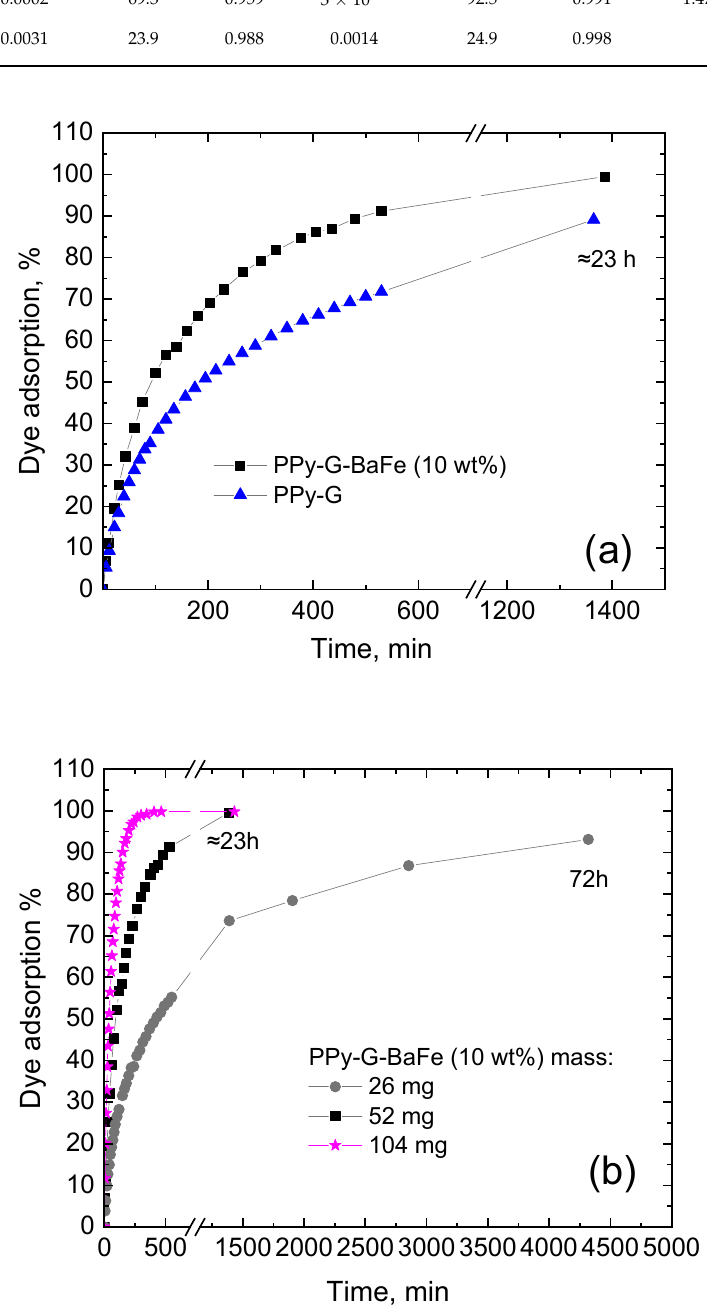
Figure 4. Adsorption of Reactive Black 5 over time by ( a ) 52 mg PPy-G-BaFe aerogel (prepared at the 10 wt% BaFe fraction) and PPy-G aerogel, and ( b ) 26 and 104 mg of PPy-G-BaFe aerogel, prepared at the 10 wt% BaFe fraction.